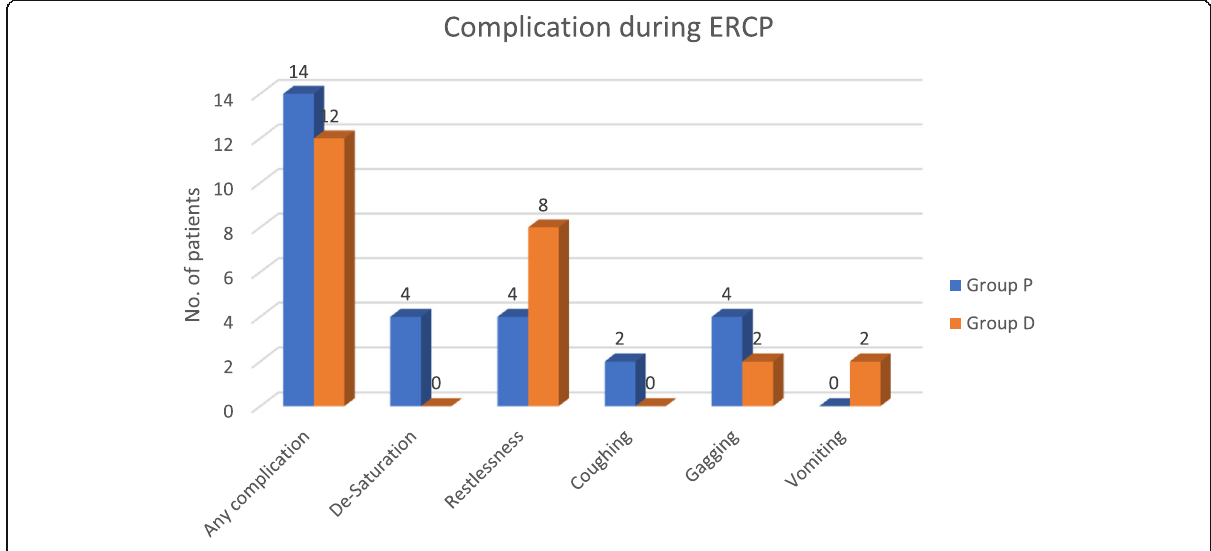
Fig. 6 Comparison of complications between the groups